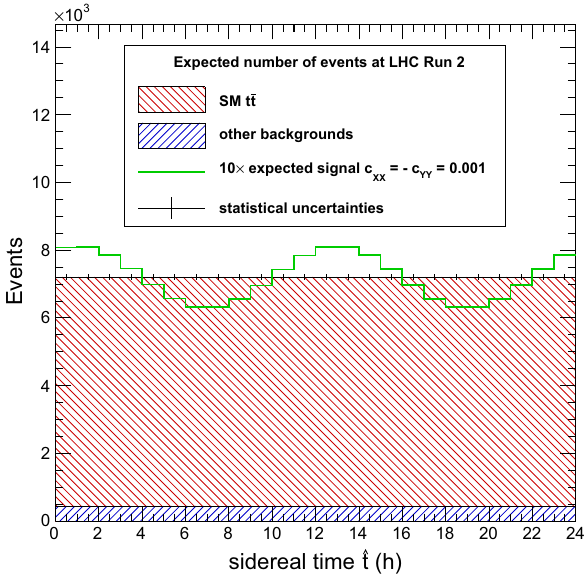
Fig. 2 Number of events expected at LHC Run 2 as a function of the sidereal time, for LIV signal in the scenario c XX = − c YY = 0 . 001, SM t ¯ t and other